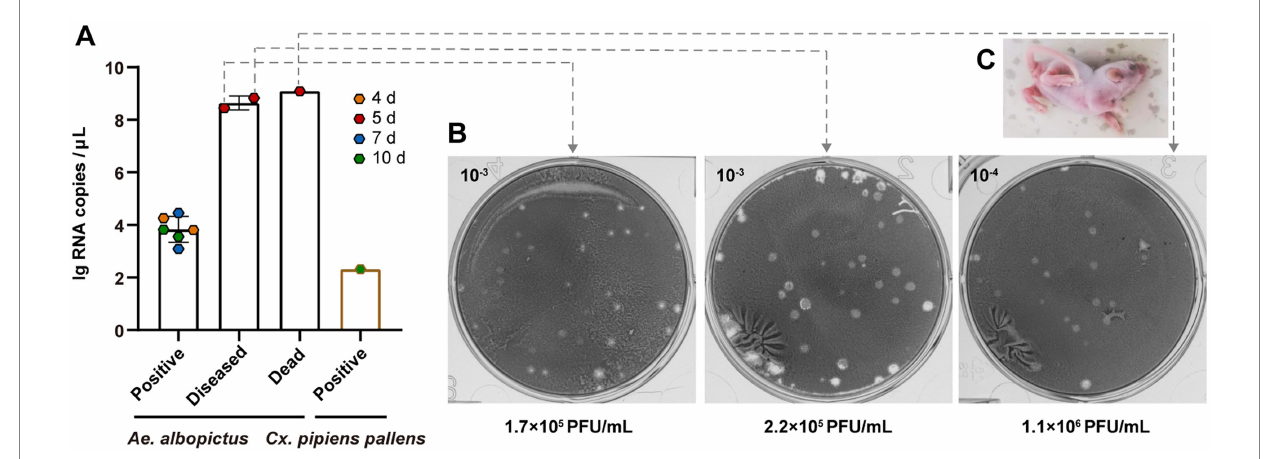
FIGURE 3 Assessment of horizontal transmission of TAHV PJ01 strain from Ae. albopictus and Cx. pipiens pallens to suckling mice. (A) RNA copies and (B) virus titers of TAHV PJ01 strain in suckling mice. (C) Physical characteristics of the diseased suckling mice.